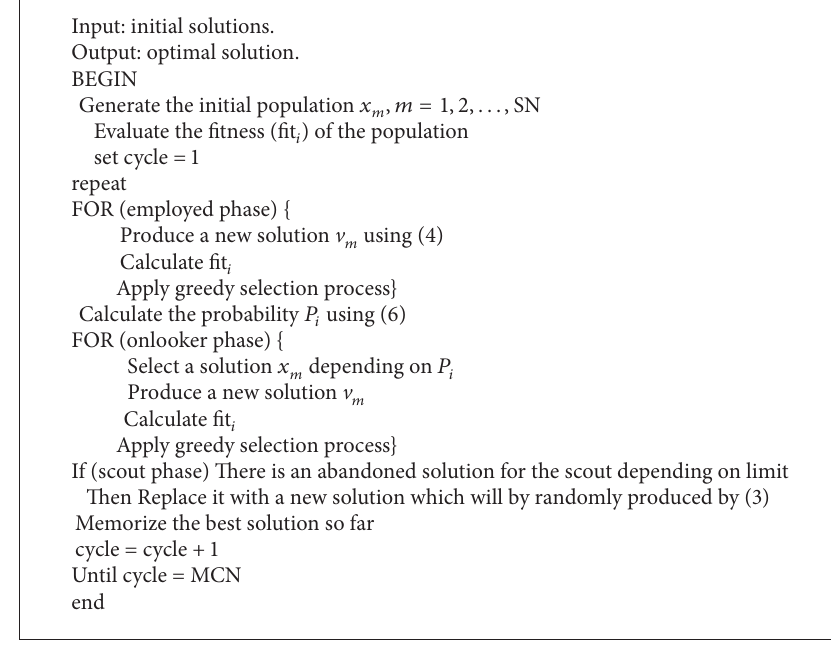
Algorithm 1: Artificial Bee Colony.